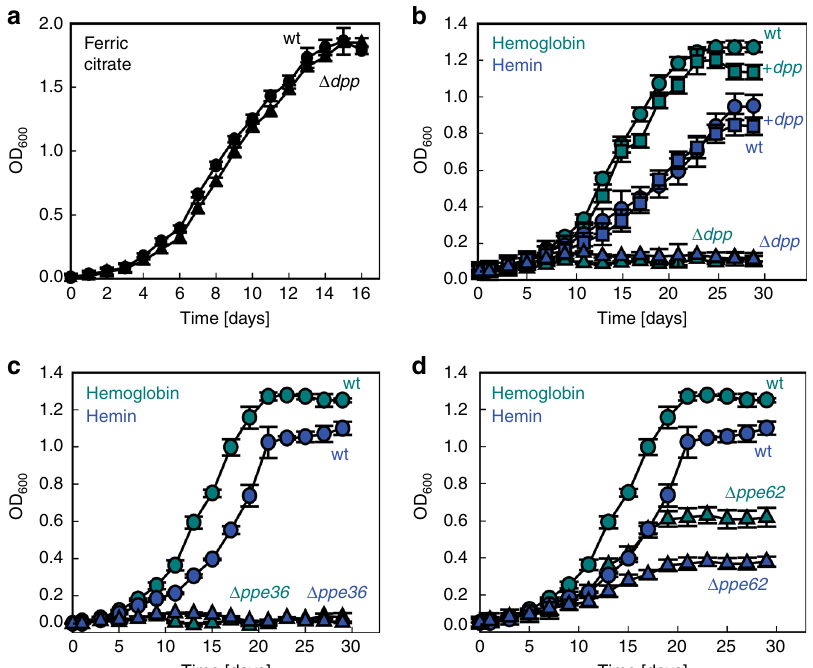
Fig. 1 Heme and hemoglobin utilization by M. tuberculosis and mutant strains. Growth of the avirulent Mtb strain mc 2 6206 (wt; circles), the Δ dpp mutant ML2436 (triangles), and the complemented Δ dpp mutant (squares) in HdB minimal medium with a 10 µ M ammonium ferric citrate and b 2.5 µ M human hemoglobin (cyan) or 10 µ M hemin (blue). Growth of Mtb mc 2 6206 (circles), the Δ ppe36 mutant ML2411 (triangles) ( c ), and the Δ ppe62 mutant ML2412 (triangles) ( d ) in HdB minimal medium with 2.5 µ M hemoglobin (cyan) or 10 µ M hemin (blue). Medium with hemin and hemoglobin contained 20 µ M of 2,2 ′ -dipyridyl to prevent utilization of trace ferric iron. Error bars represent standard errors of mean values of biological triplicates. Source data are